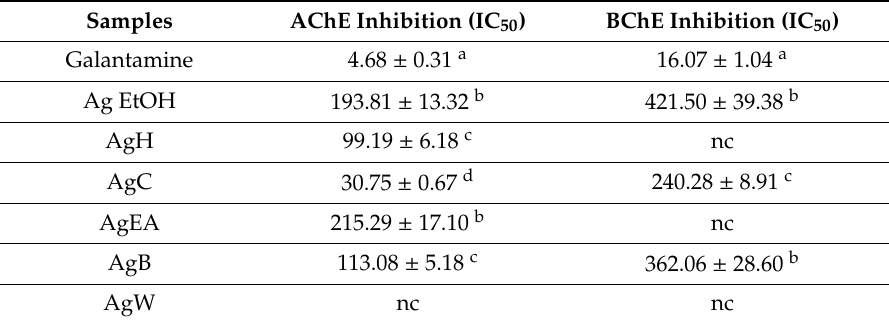
Table 3. AChE and BChE inhibition by galantamine and Azorella glabra samples expressed as IC 50 values in µ g / mL.